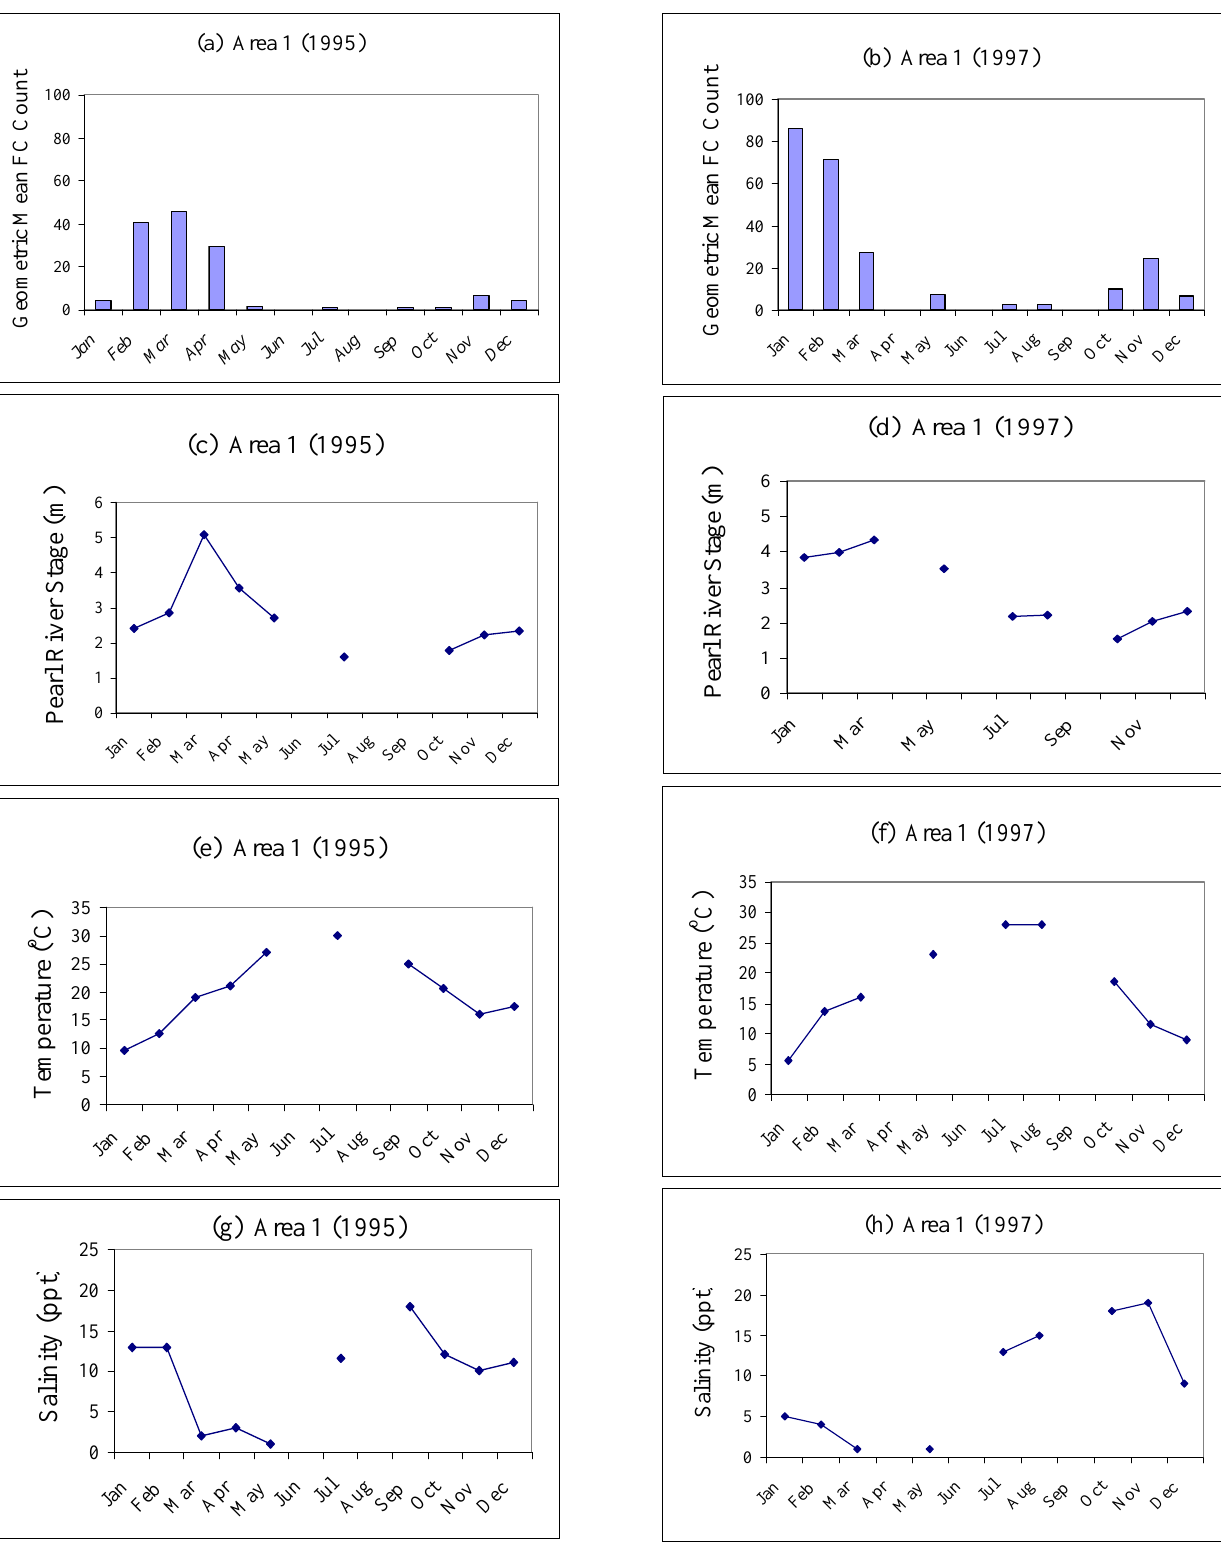
Figure 2: Seasonal variations in the geometric mean fecal coliform abundance, Pearl River stage, water temperature and salinity in the western part of Mississippi Sound in 1995 and 1997. No samples were collected for fecal coliforms (June & August), Pearl River stage (June, August & September), temperature (June & August), and salinity (June & August) in 1995. Samples were also not collected for fecal coliform counts, Pearl River stage, water temperature and salinity in April, June and September